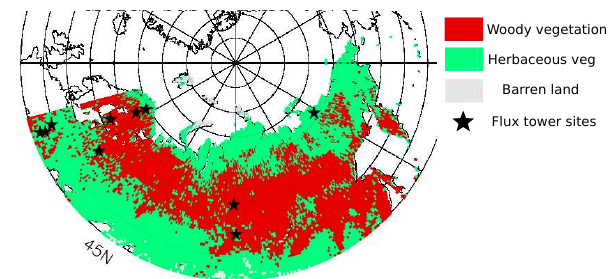
Figure 1. Simplified land cover for northern Eurasia for year 2007 overlaid with the spatial distribution of the 10 flux tower sites whose GPP (gross primary productivity) data were used to validate the GPP data derived from satellite NDVI (normalized difference veg- etation index). For our statistical analysis, we show the distribution of two fundamental types of vegetation types: (i) herbaceous, i.e. without woody stems, which includes tundra in the north and grass- lands (Eurasian Steppe) to the south, and (ii) wooded, i.e. plants with wood as its structural tissue, which includes the boreal forests appearing in the middle and extending from the western to the east- ern boundary. This land cover map has been derived from the Mod- erate Resolution Imaging Spectroradiometer (MODIS) Type 5 land cover product (Friedl et al., 2002). The details of the flux tower sites are listed in Table